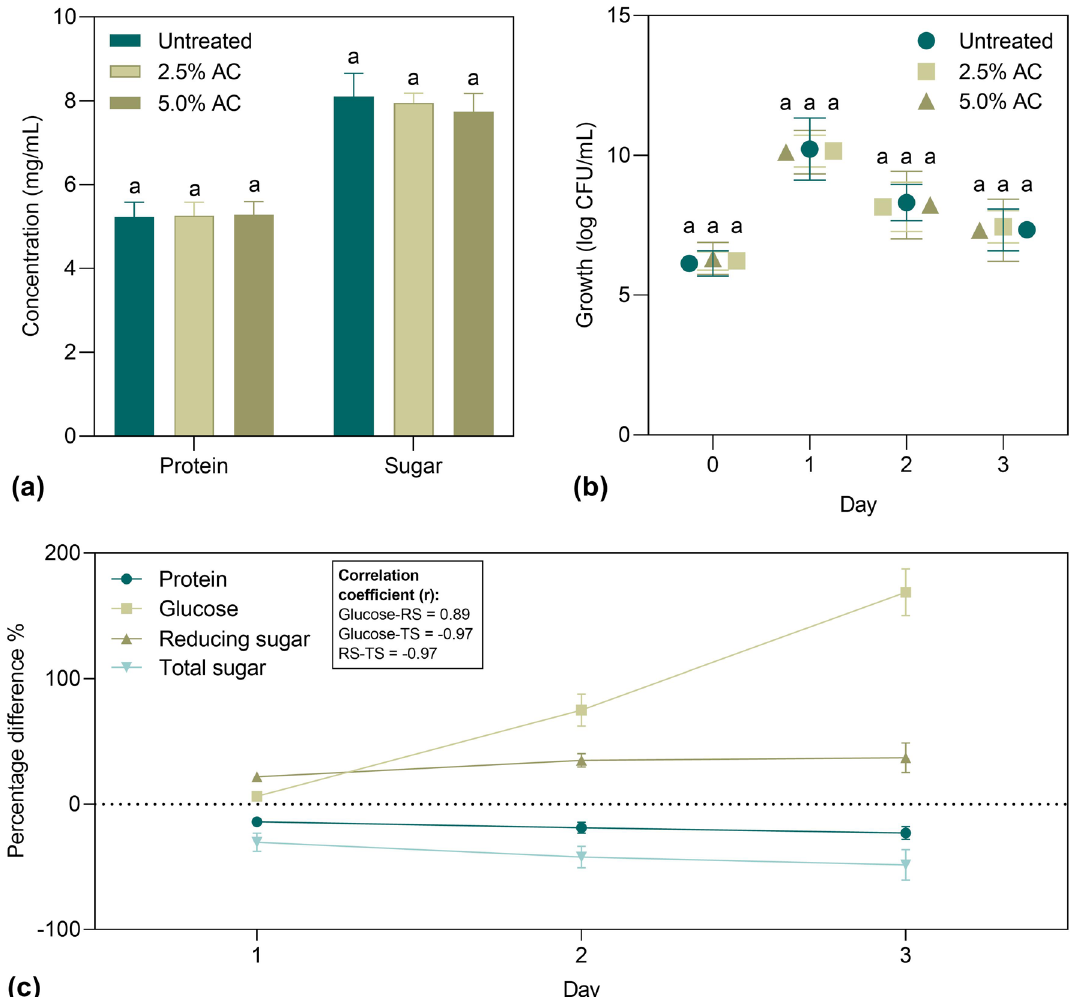
Figure 4. Biocompatibility assay of DSM-JP hydrolysate: ( a ) detoxification of hydrolysate using activated carbon (AC); ( b ) Growth of strain 40a in a raw and a detoxified hydrolysate media ( c ). nutrient utilization dynamics during 3-day growth of strain 40a. Data represent mean values ± standard deviations (n = 3). Different letters indicate statistically significant differences between factors (two-way ANOVA + Tukey multiple comparisons test at P < 0.05). The correlation coefficient was calculated by Pearson correlation. The graphs were visualized in GraphPad PRISM software (v 8.02; GraphPad, Inc., MN, USA; www. graph pad.